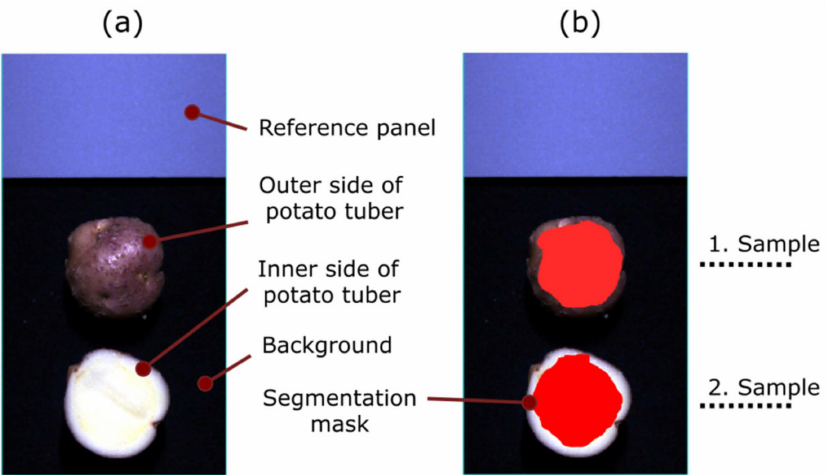
Figure 3. Hyperspectral image of tubers prior to segmentation. ( a ) With labelled segmentation class which construct the image. ( b ) Same image with applied segmentation masks of potato tubers and labelled consecutive sample